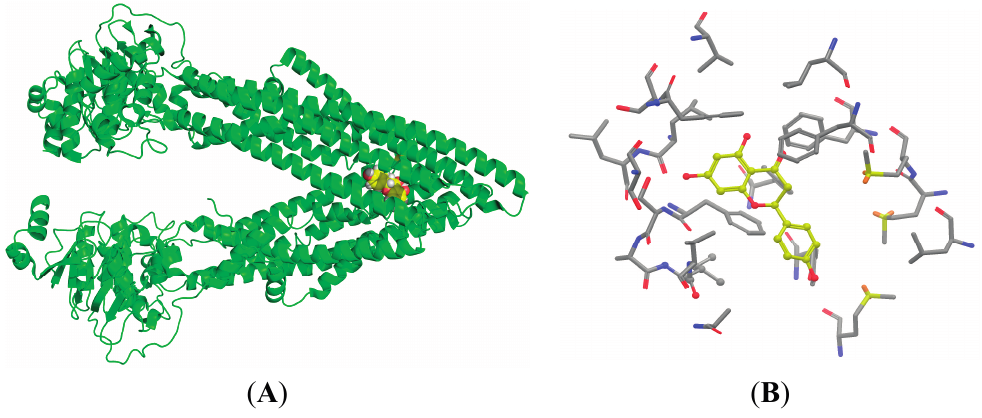
Figure 8. The binding site (yellow) of NCB (cyan) to P-gp was analyzed by docking simulation. NCB, with a higher number of hydrophobic features and hydrogen bond acceptors, was more prone to P-gp binding. Moreover, the binding site of NCB to P-gp lies beside Phe332, Phe728 and Phe 974 in chain A. The benzene ring of NCB could also have a parallel π - π interaction with the benzene ring of P-gp. The rotations of all single bonds of the ligand and the side chains of residues within 5 Å of the ligand were considered.